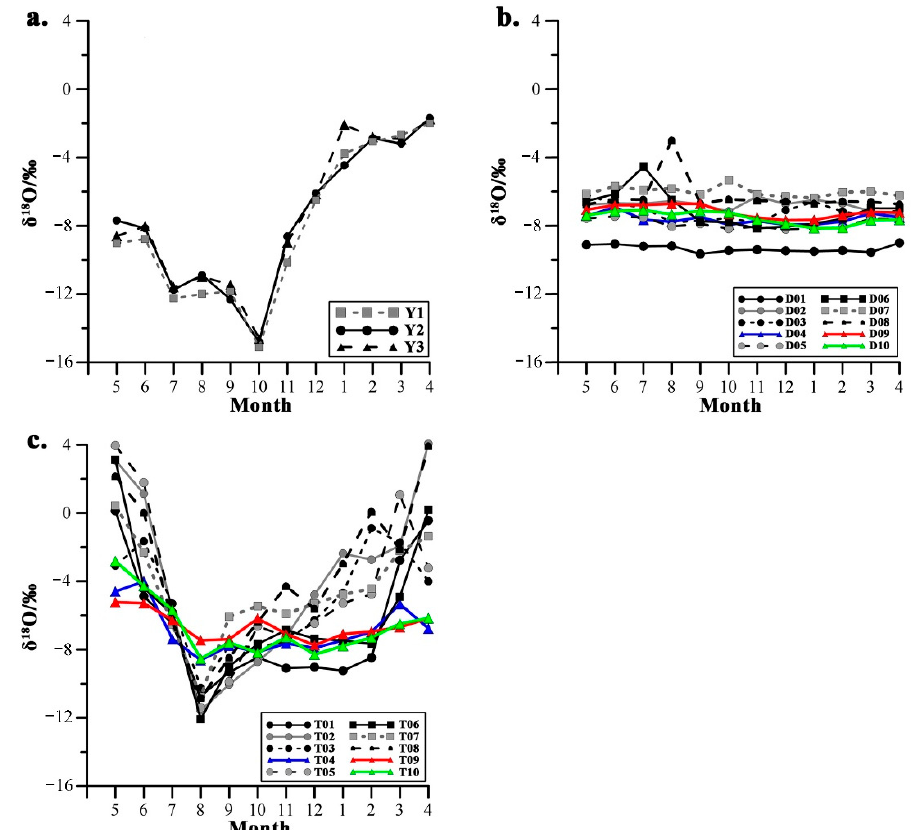
Figure 4. ( a ) The spatial and temporal distributions of δ 18 O in precipitation, ( b ) the spatial and temporal distributions of δ 18 O in groundwater, ( c ) the spatial and temporal distributions of δ 18 O in terrace water.